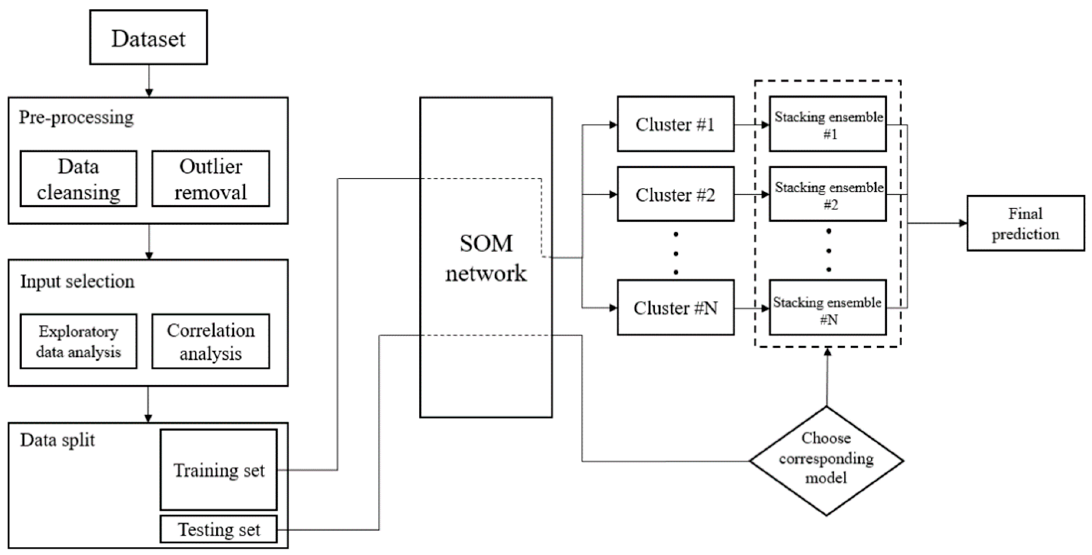
Table 1. Input data matrix.